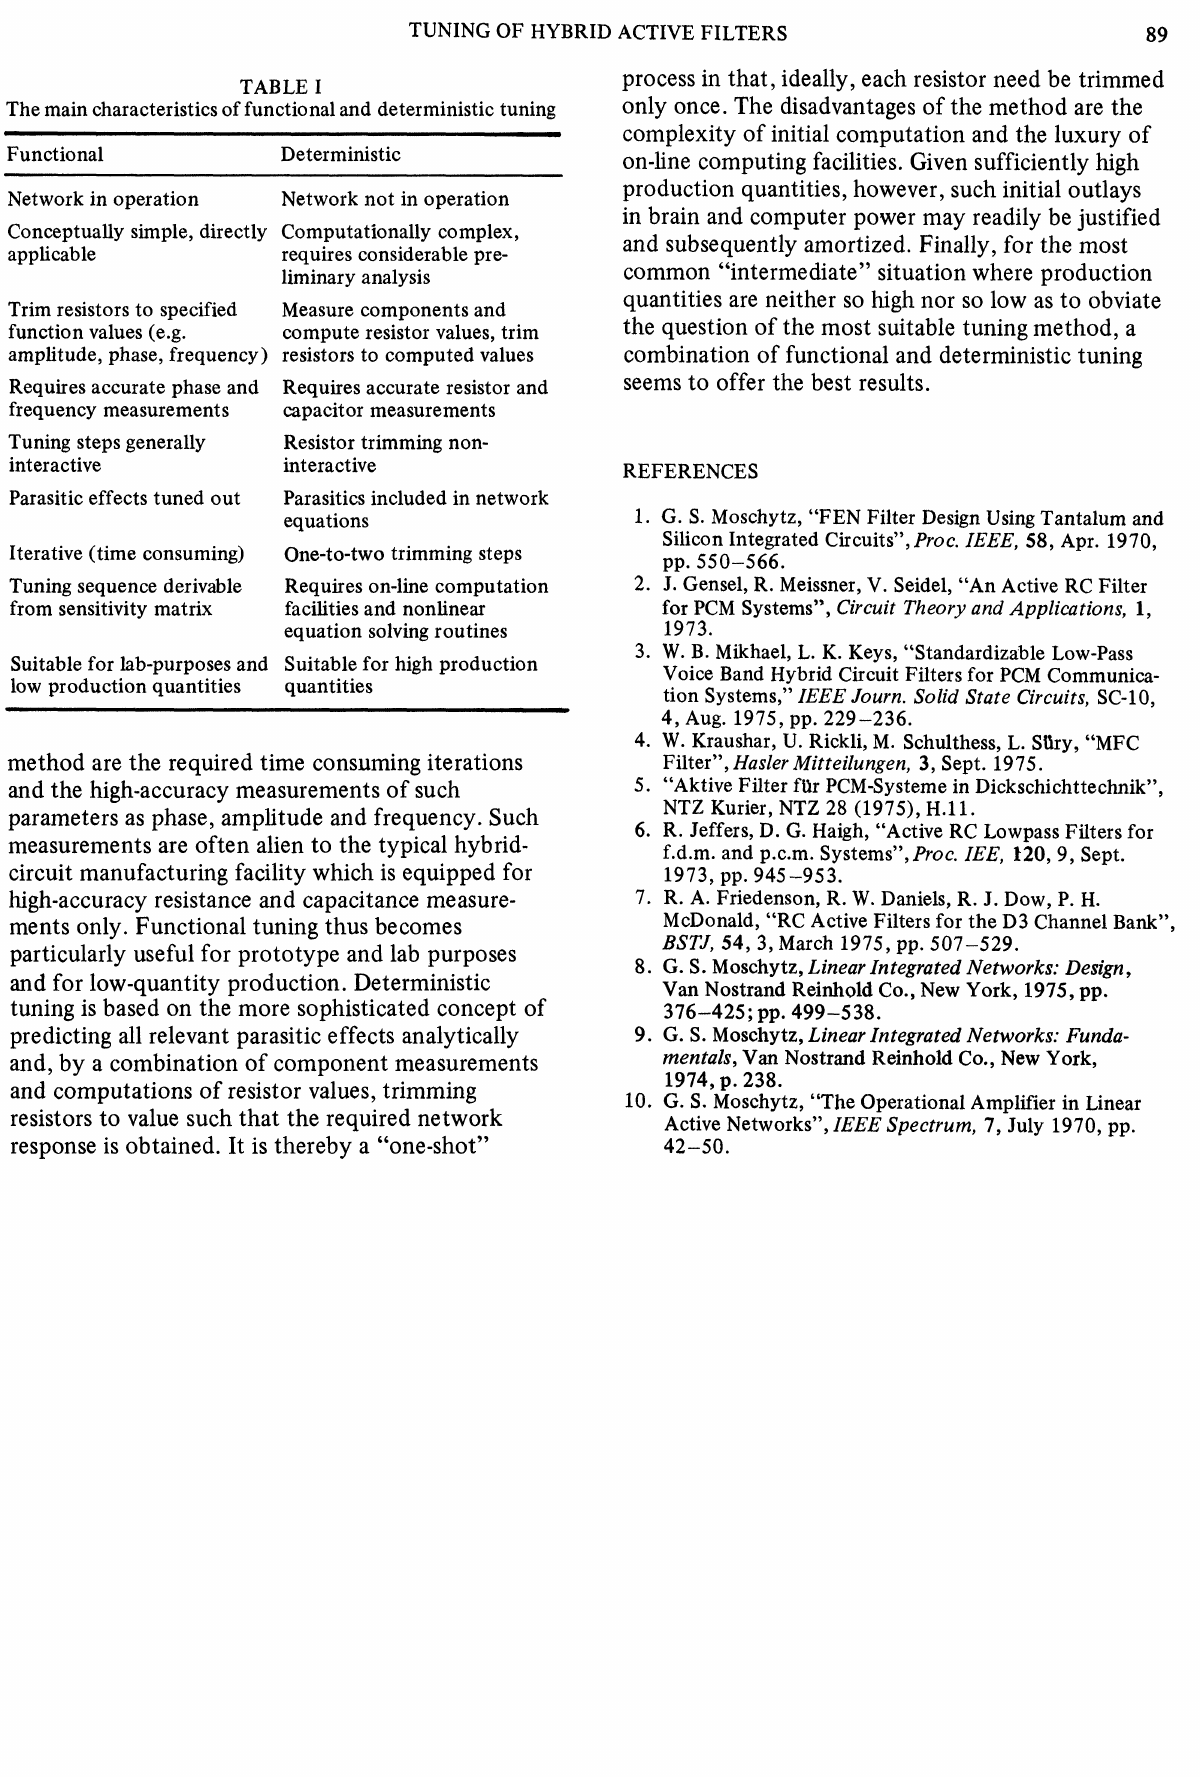
TABLE The main characteristics of functional and deterministic